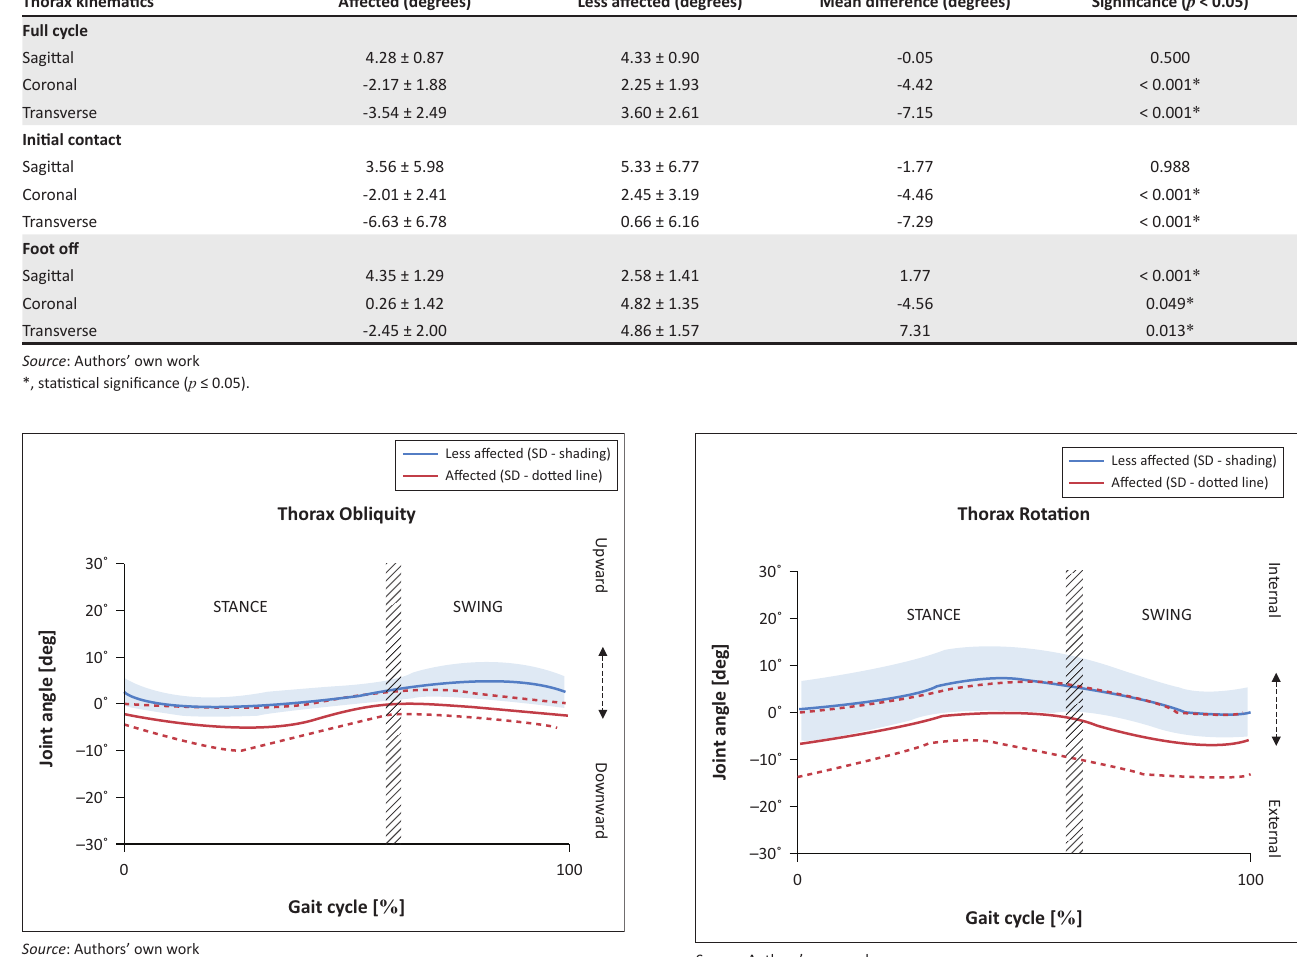
TABLE 2: Mean (standard deviation) peak trunk angle during the full gait cycle, in the sagittal, coronal and transverse planes as well as at initial contact and foot off. Thorax kinematics Affected (degrees) Less affected